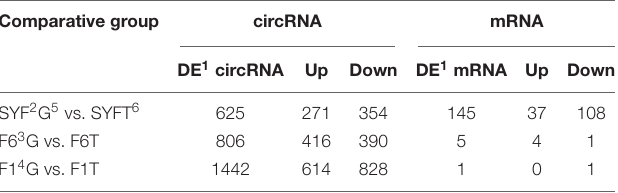
TABLE 1 | Numbers of differentially expressed transcripts in different comparisons of RNA-Seq experiments. Comparative